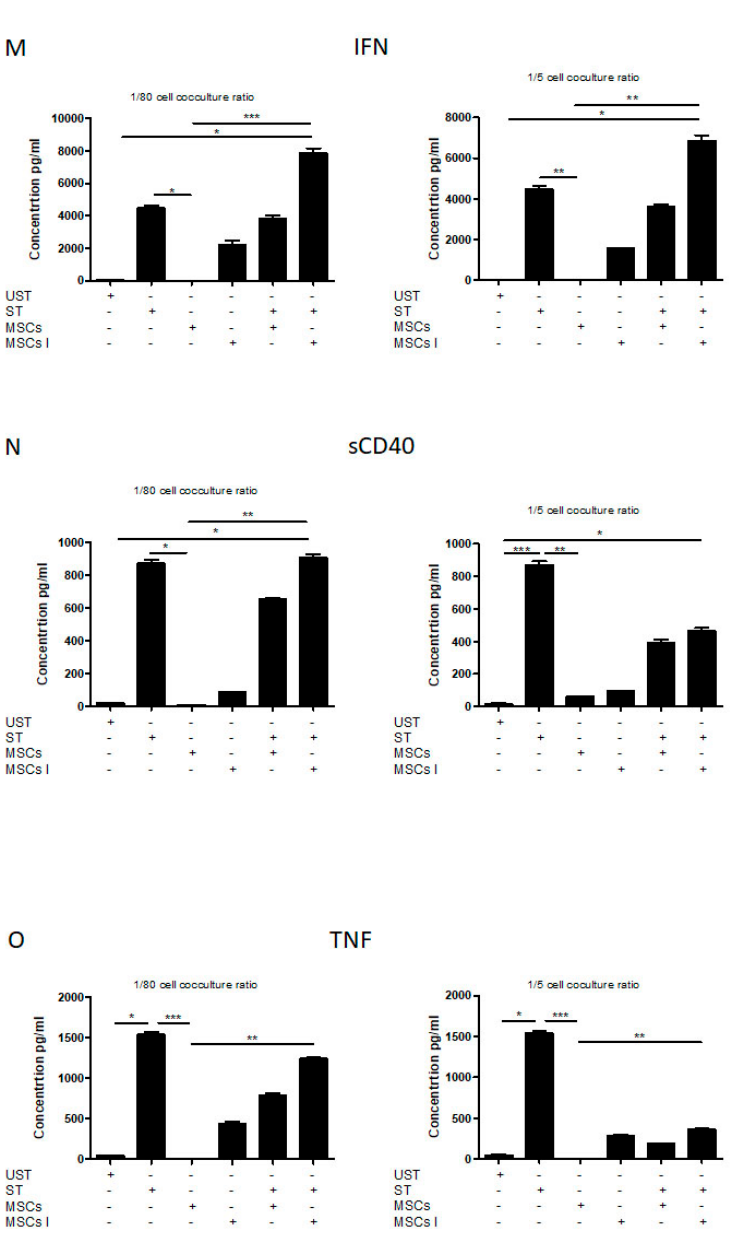
Figure 6. Th17-associated cytokine array profile. FSK-MSCs were cocultured at a (1:5) or (1:80) cell ratio under normal and inflammatory conditions with either unactivated or PHA/IL-2-activated T cells as indicated. The levels of the different cytokines were analyzed as indicated in the Materials and Methods section. Data are presented as the concentration ± SEM (pg/mL) for IL-1 β ( A ), IL-4 ( B ), IL-6 ( C ), IL-10 ( D ), IL-17A ( E ), IL-17F ( F ), IL-21 ( G ), IL-22 ( H ), IL-23 ( I ), IL-25 ( J ), IL-31 ( K ), IL-33 ( L ), INF- γ ( M ), sCD40 ( N ), and TNF- α ( O ) from seven independent experiments. * p < 0.05, ** p < 0.01, *** p < 0.01 versus the corresponding control. UST: unstimulated lymphocytes; FSK-MSC: foreskin- derived mesenchymal stromal cell; IL: interleukin; PHA: phytohemagglutinin; ST lymph: PHA/IL-2 stimulated lymphocytes; FSKi MSC: inflammatory primed MSCs.